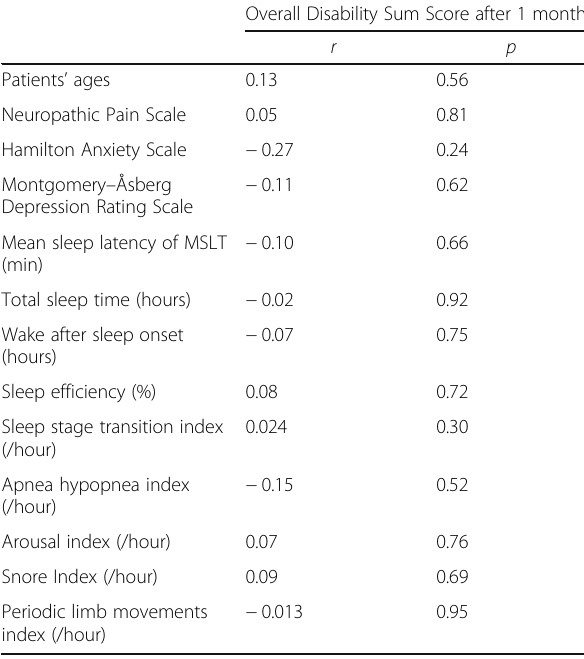
Table 3 Correlations of the Overall Disability Sum Score and other studied parameters, 1 month after finishing